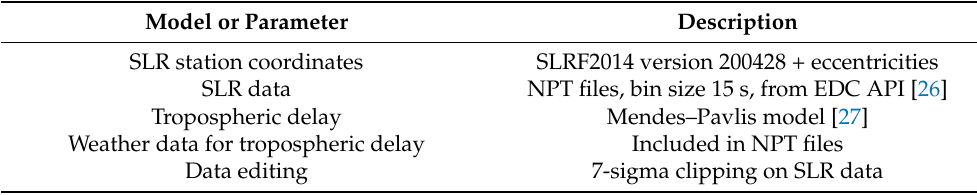
Table 4. Additional parameters for TUBIN orbit determination from SLR range